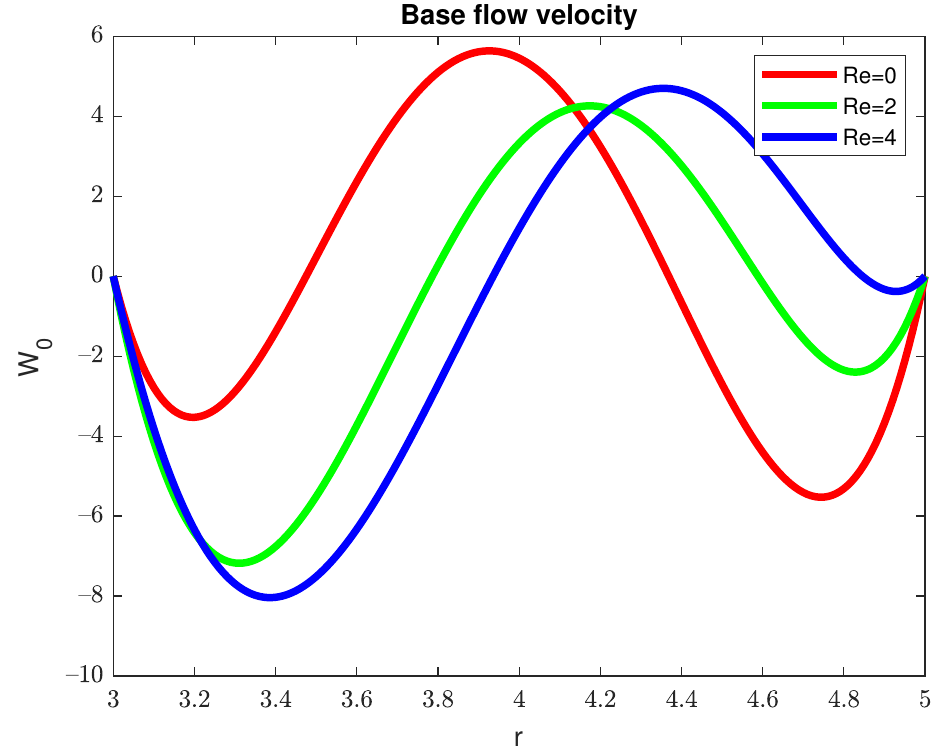
Figure 1. Base flow velocity distribution for F = 0.5 and η =